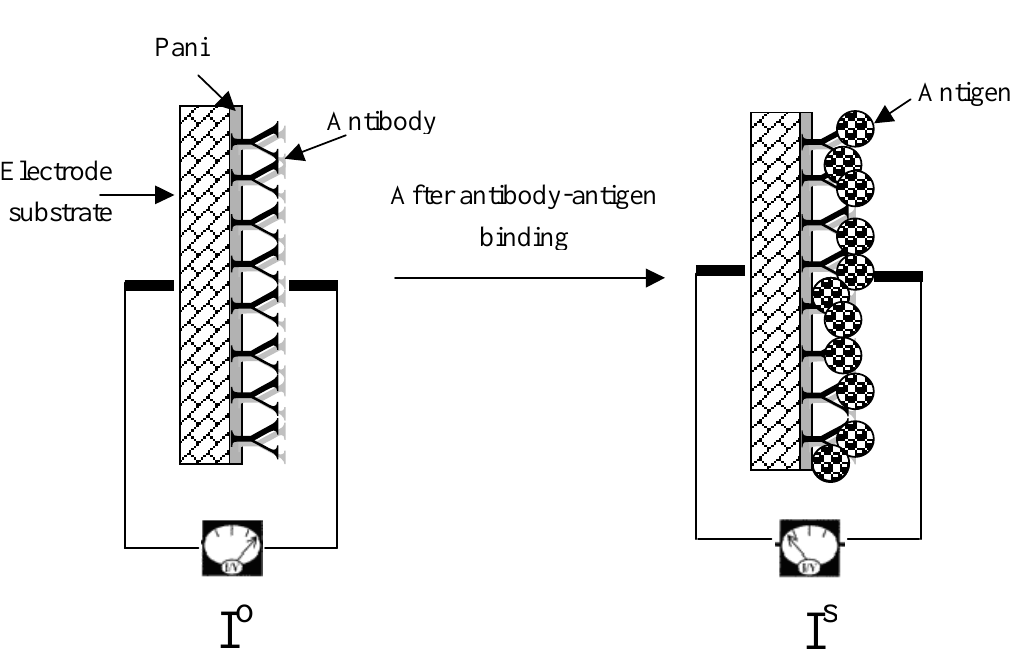
Figure 7. Schematic of an ITO-Pani biosensor before and after antibody-antigen binding.